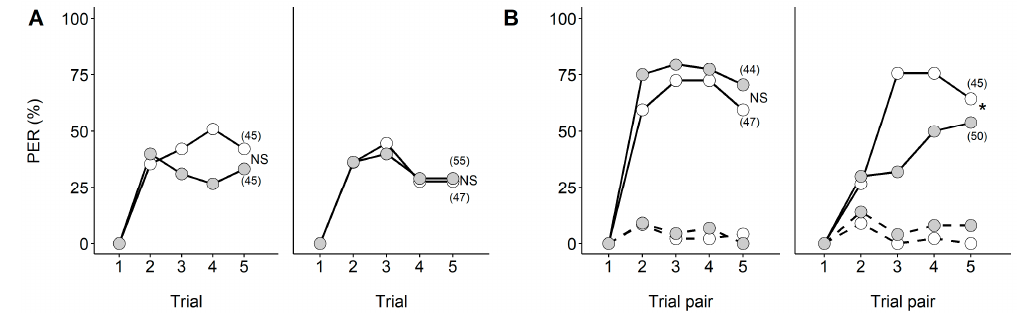
Figure 6. Effect of chronic exposure to GLY on young honey bee absolute and differential olfactory learning. Bees were reared in cages that offered sucrose solution alone (control, white circles) or with GLY (grey circles, 2.5 mg L − 1 ) and were evaluated at five or nine days old (from left to right